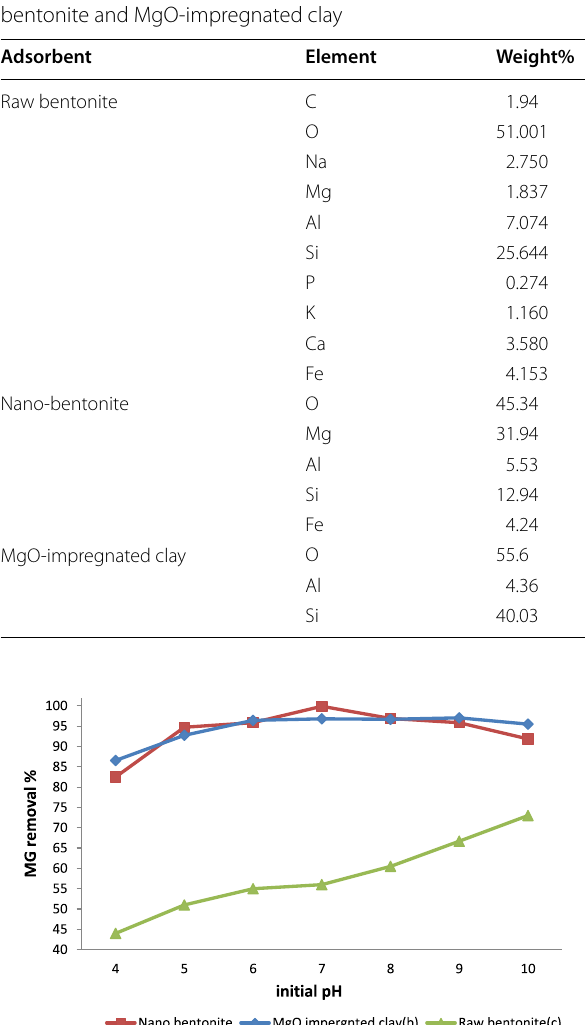
Fig. 6 Effect of pH on MG dye removal by a nano-bentonite, b MgO impregnated clay and c raw